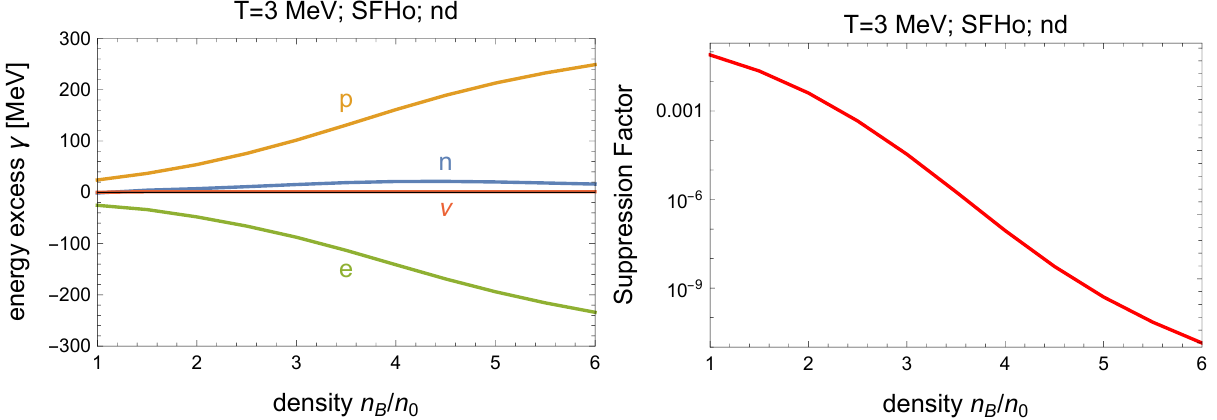
Figure 13. The optimal kinematics for neutron decay at T = 3MeV for SFHo, obtained by maximizing the Fermi-Dirac products. The suppression factor, e −| γ e | / T e −| γ n | Θ ( γ n ) / T is dominated by the difficulty of finding an electron hole below its Fermi